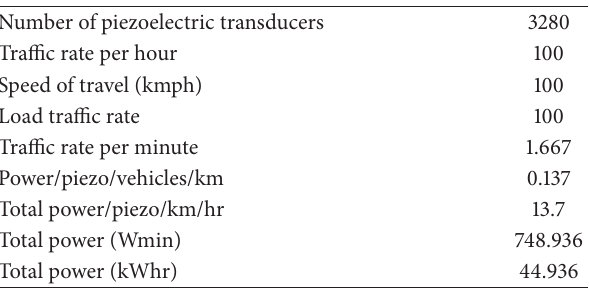
Table 4: Total power generation per piezoelectric transducer.